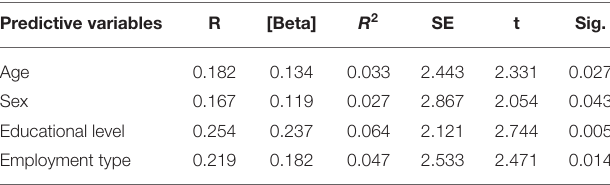
TABLE 4 | Regression and effect coefficients of social capital in moral courage. Predictive variables R [Beta] R 2 S E t Sig.